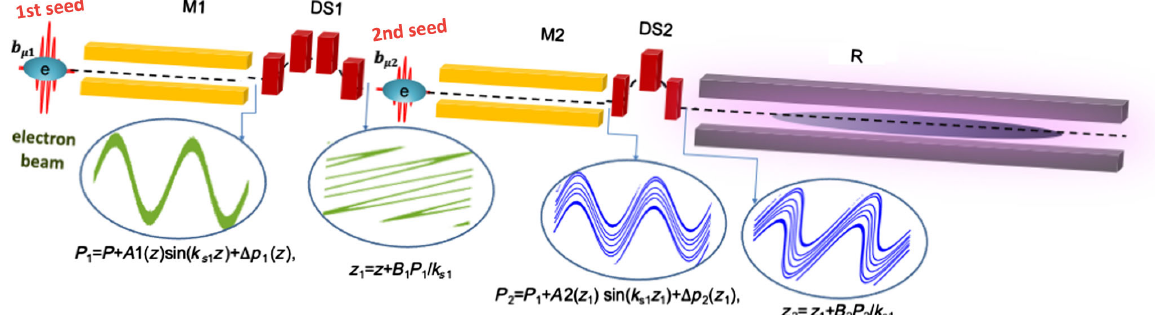
FIG. 1. Main components of the EEHG scheme: first modulator (M1), strong first dispersive section (DS1), second modulator (M2), and weaker second dispersive section (DS2). Equations refer to quantities of the electron beam longitudinal phase space introduced in Eq. (1). In particular, Δ p 1 ; 2 is the incoherent energy modulation [see Eq. (2)] and b μ 1 ; μ 2 is the incoherent bunching factor [see Eq. (13)]. After DS2, the nano-bunched electron beam travels into the radiator (R) and emits coherent and powerful light